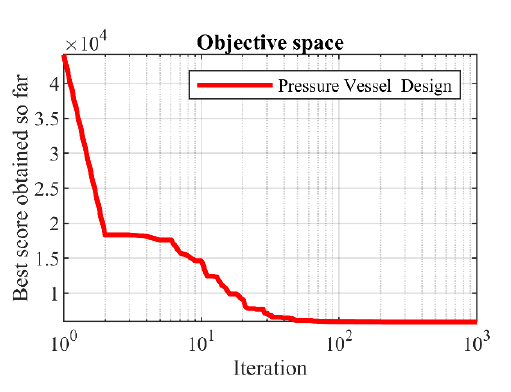
Figure 9. SSVUBA’s performance convergence curve in the pressure vessel design.